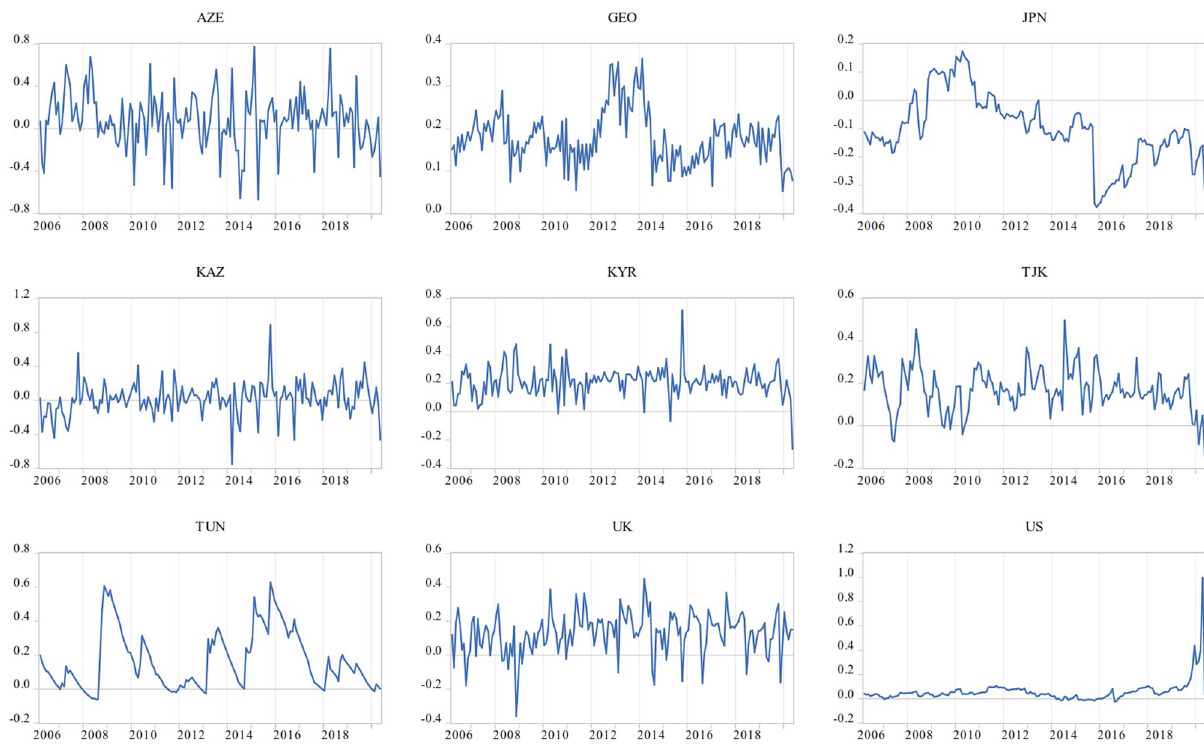
Fig. 2 Plots of time-varying conditional